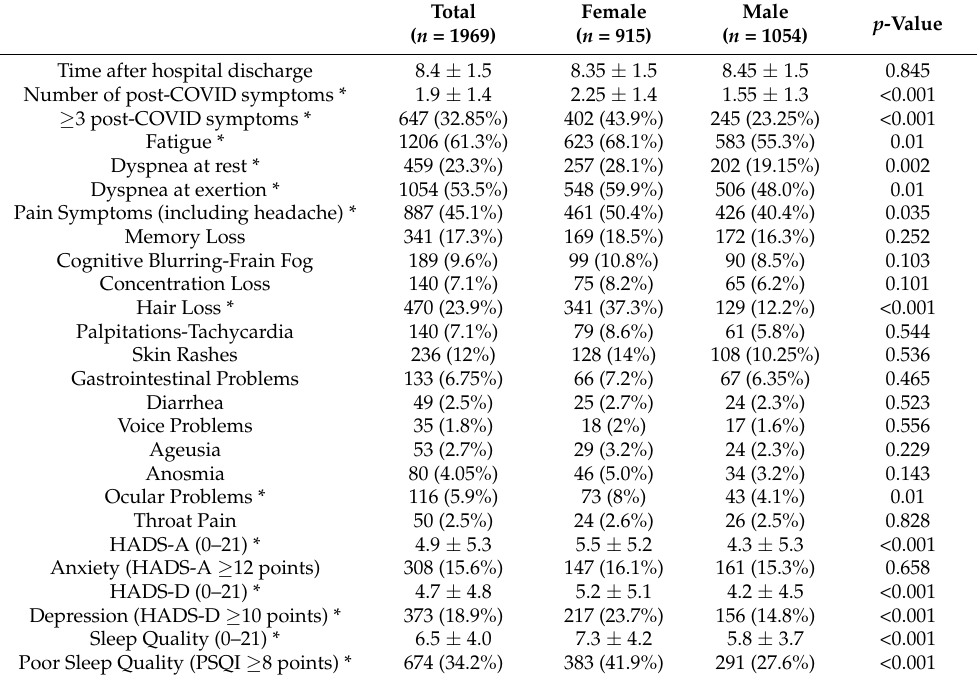
Table 2. Post-COVID symptoms and psychological symptoms according to